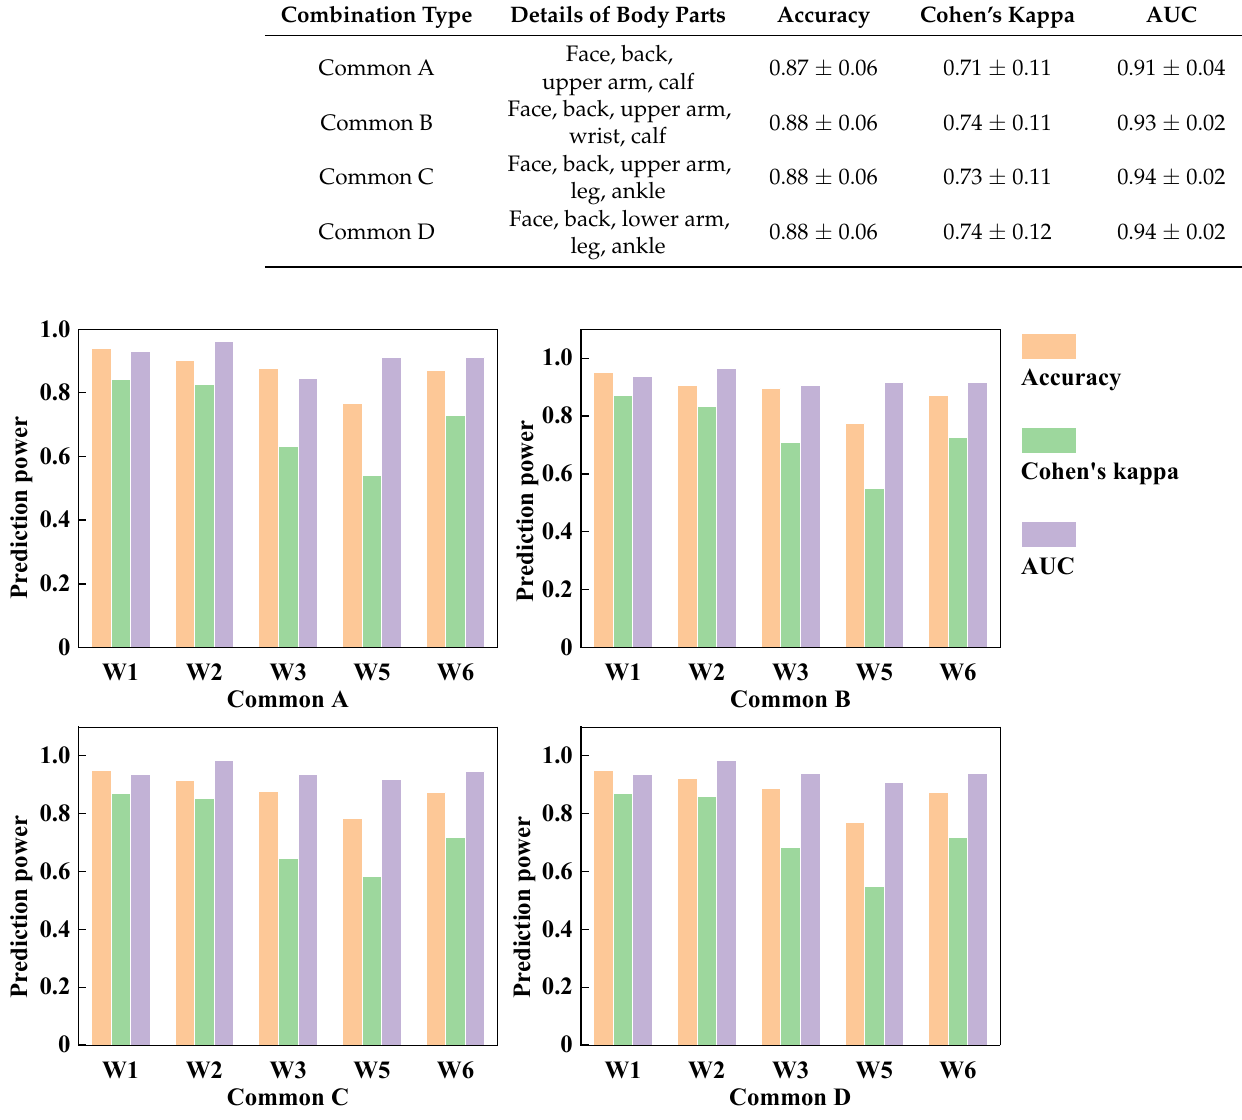
Table 4. The subject-averaged prediction power of four common combinations for subjects W1-W6.